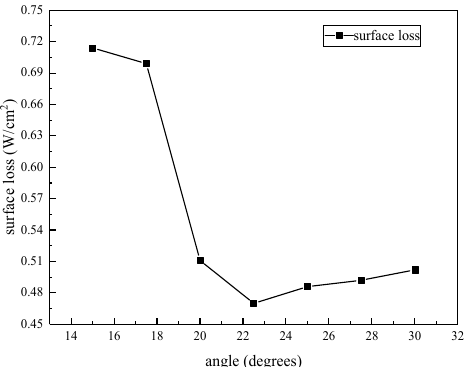
Figure 11. Maximum electric stress at various angles.